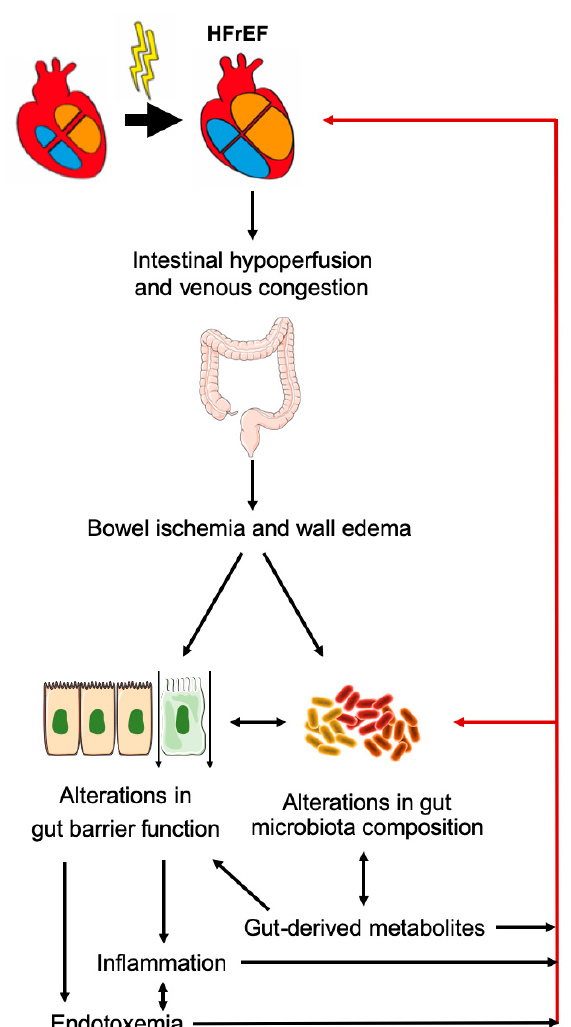
Figure 3. Gut-heart crosstalk in heart failure with reduced ejection fraction (HFrEF).